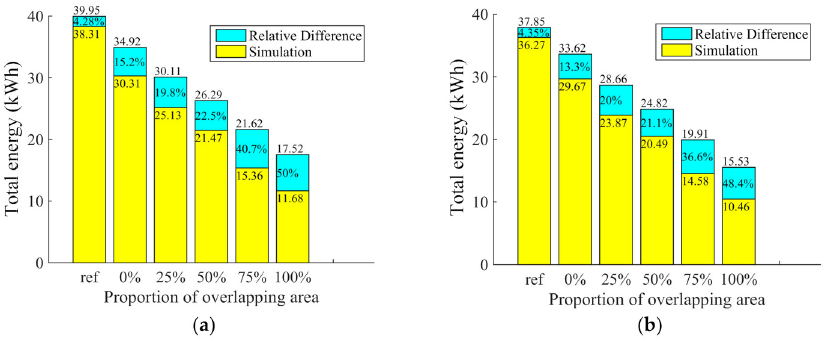
Figure 11. Energy acquisition of different overlapping areas. ( a ) Total energy of wing section 3. ( b ) Total energy of wing section